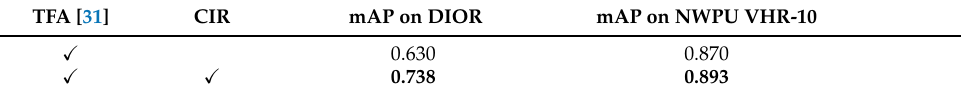
Table 7. Ablation experiment of Base categories.